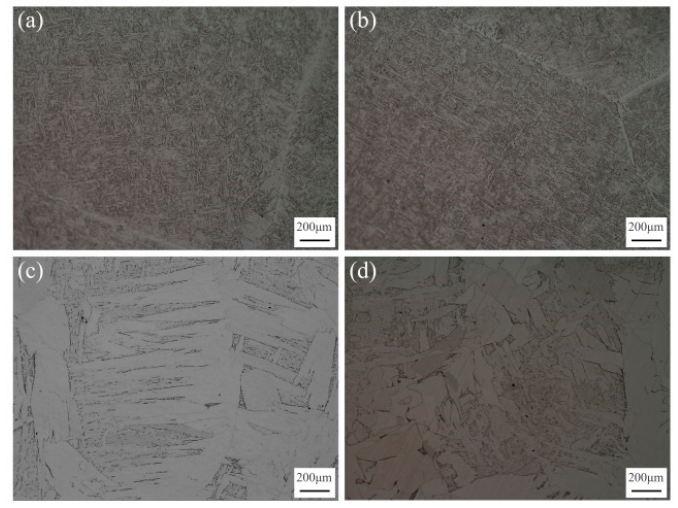
Figure 5. ( a , b ) The EAM-treated sample’s optical microstructure. ( c , d ) The non-treated sample’s optical microstructure.